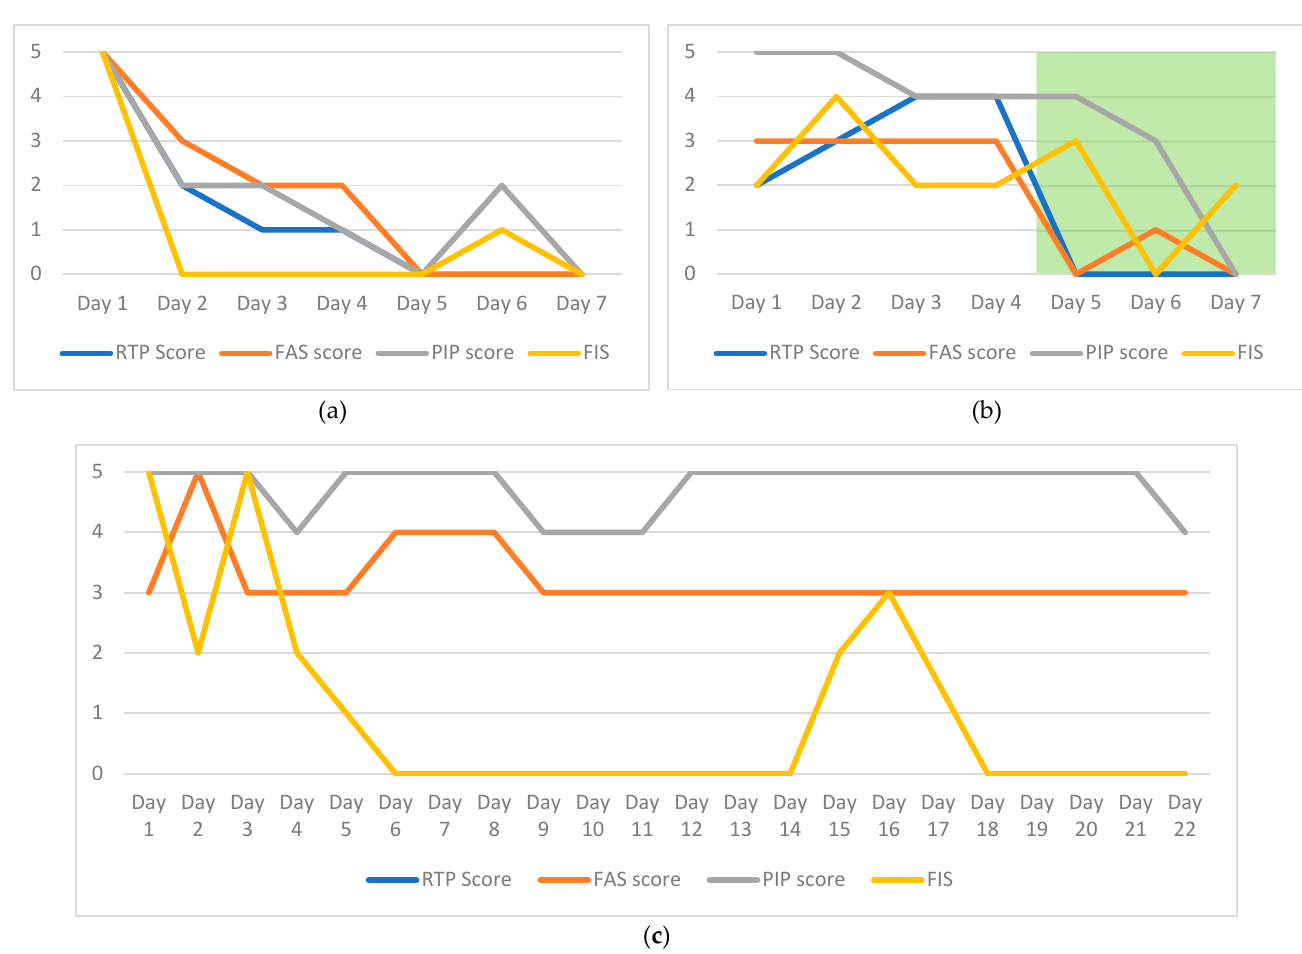
Figure 1. Evidence of an initial stress response to shelter housing, with gradual improvement through habituation ( a ); evidence of an initial stress response to shelter housing that reduced in response to administration of gabapentin (green block); ( b ); evidence of an initial stress response to shelter housing without improvement (with the exception of increased food intake) despite interventions ( c ). RTP: Response to Petting; FAS: Fear, Anxiety, and Stress; PIP: Participation in Play; FIS: Food Intake Summary.